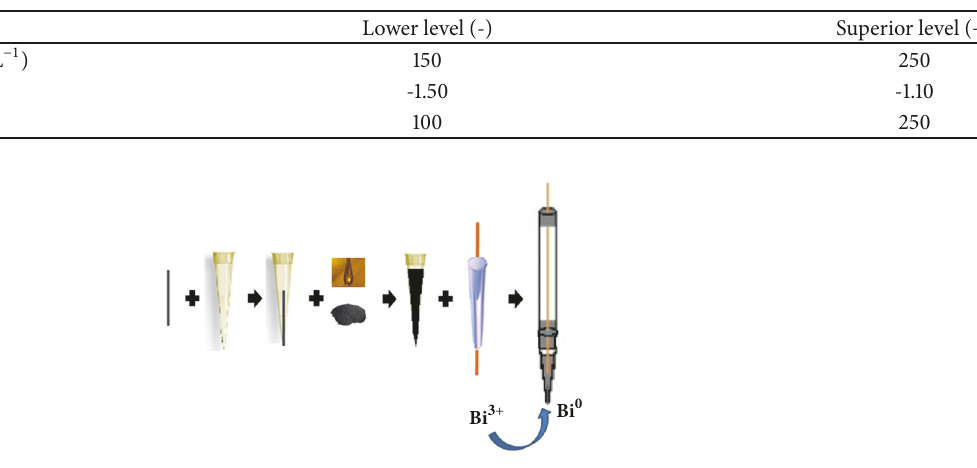
Table 1: Factors and respective lower and superior levels values.